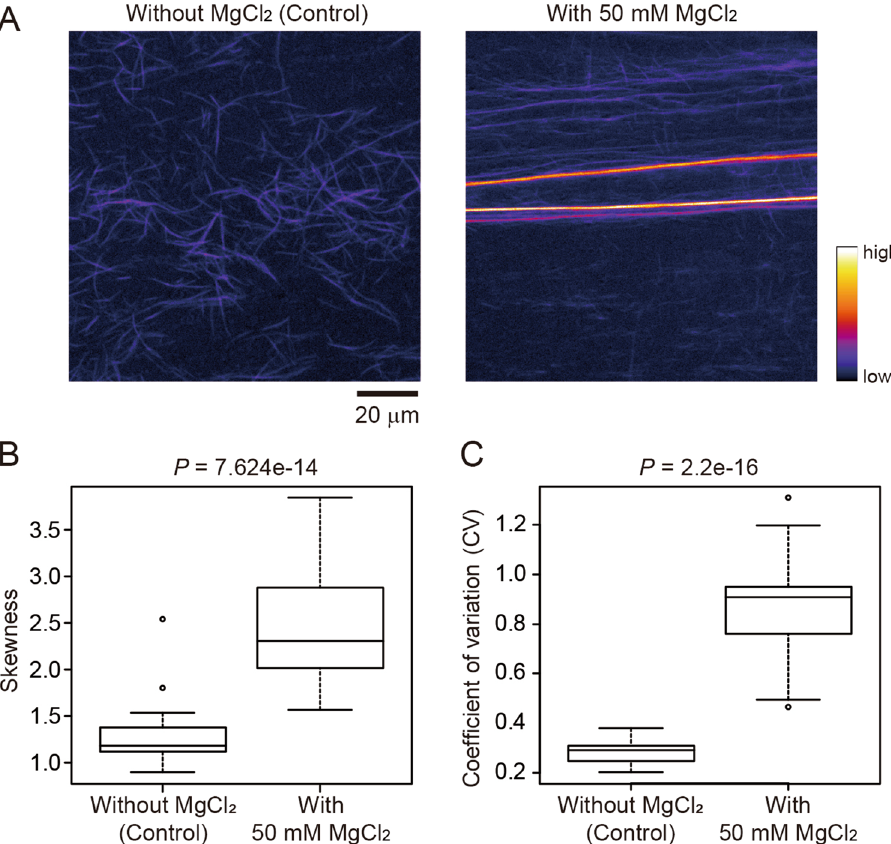
Figure 2. Evaluation of actin filament bundling in vitro. ( A ) Representative confocal laser scanning microscopy images of in vitro ATTO 390-labeled actin filaments. Control images (left) and those with bundling due to the addition of MgCl 2 (right) are shown. Scale bar indicates 20 μm. ( B ) Skewness of the intensity distribution. ( C ) CV of intensity distribution. Significance was determined using the Mann–Whitney U-test. N =